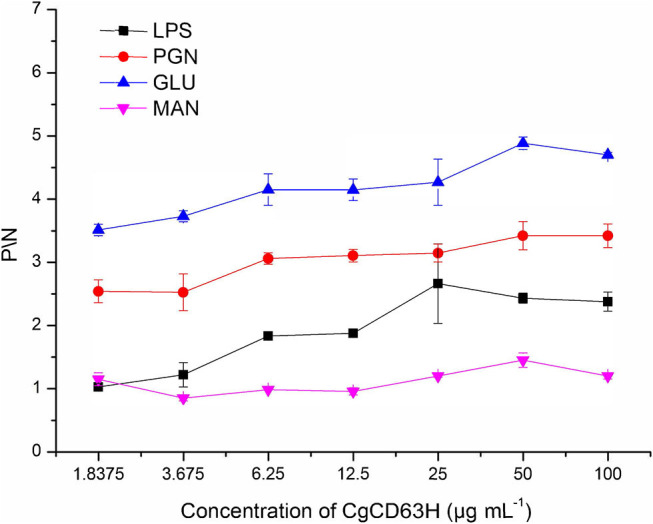
ELISA analysis of the interaction between CgCD63H and the pathogen-associated molecular patterns (PAMPs). Plates were coated with LPS, PGN, GLU, and MAN, and then incubated with a series of concentrations of rCgCD63H and rTrx at the presence of lyophilized hemolymph at 18°C for 2 h. After incubated with anti-CgCD63H, the interaction was detected with goat antimouse Ig-alkaline phosphatase conjugate at 405 nm. Samples with P/N (Psample – Bblank/Nnegative – Bblank) > 2.1 were considered positive. Results are representative of the mean of three replicates ± SE.